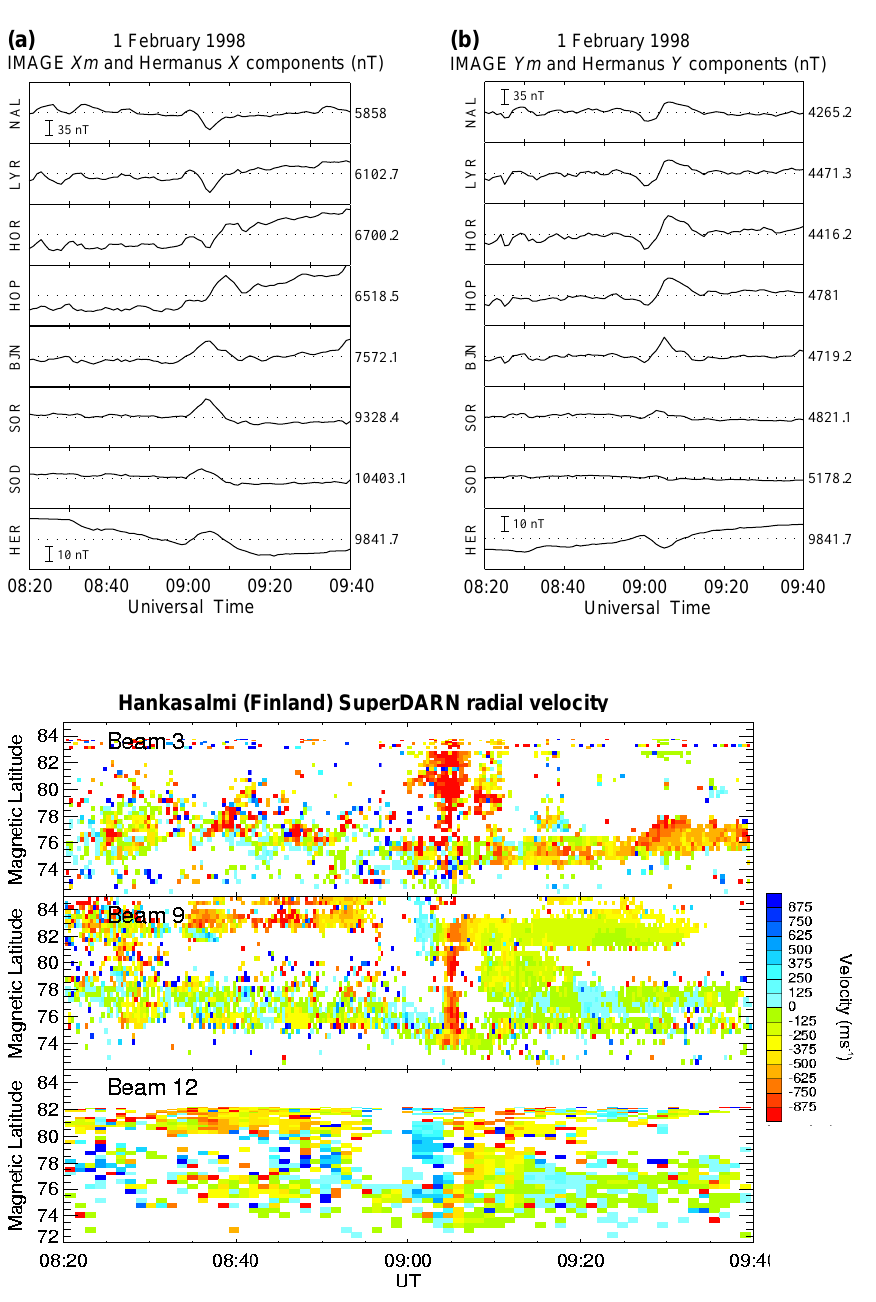
Fig. 5. Radial velocities in 3 beam di- rections of the Hankasalmi